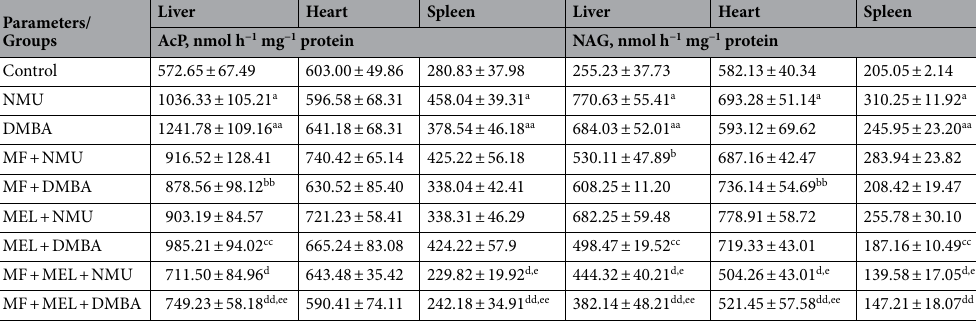
Table 2. Effect of melatonin and metformin on acid phosphatase and β- N -acetylglucosaminidase activity (nM/h/mg protein) in the liver, heart and spleen in female Sprague-Dawley rats subjected to a high-fat diet in the mammary carcinogenesis model induced by N -methyl- N -nitrosourea (NMU) or dimethylbenzanthracene (DMBA). Metformin (MF) or melatonin (MEL) was administered alone and in combination (MF + MEL). Note. Data are expressed as means ± S.D. Significant differences P < 0.05 are designated as follows: a—NMU group vs. control group; aa—DMBA group vs. control group; b—MF +